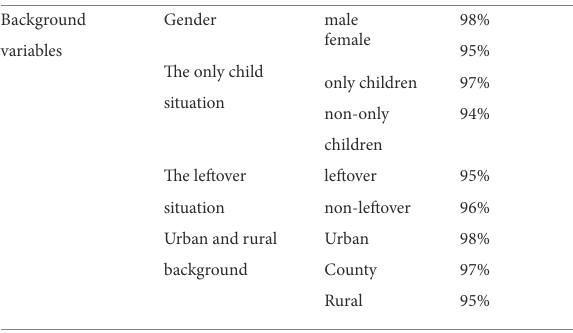
TABLE 2 The compliance rate of middle school students’ mathematical problem-solving performance. The compliance rate of middle school students’ mathematical problem-solving performance in mainland China (C level and